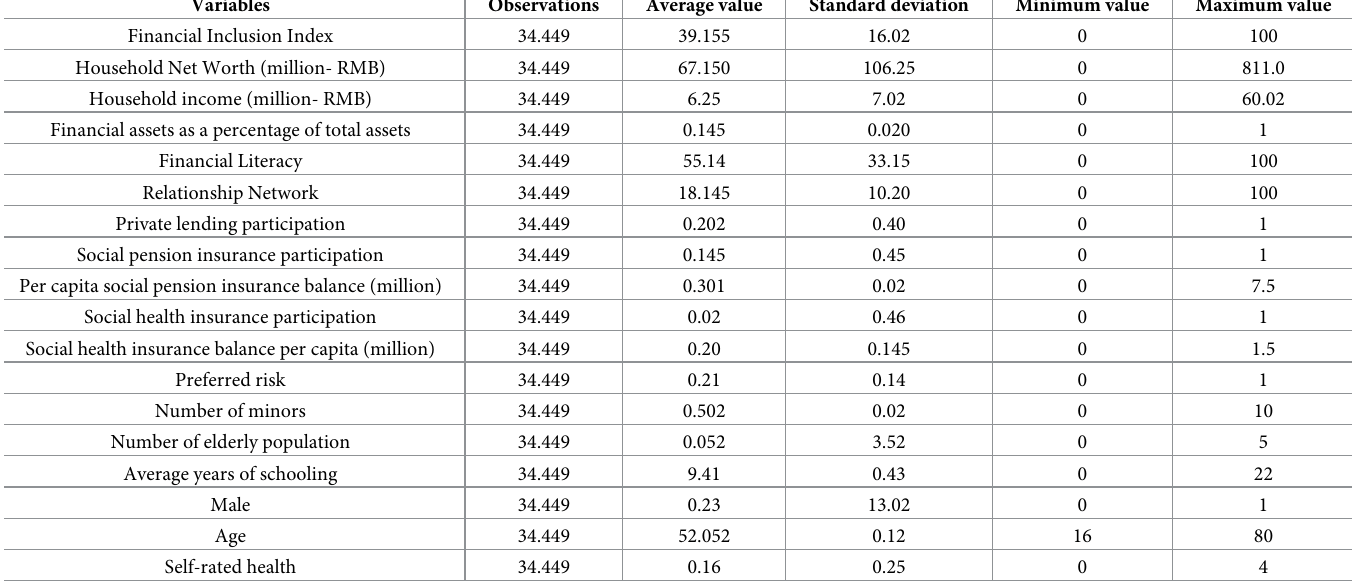
Table 3. Descriptive statistics of